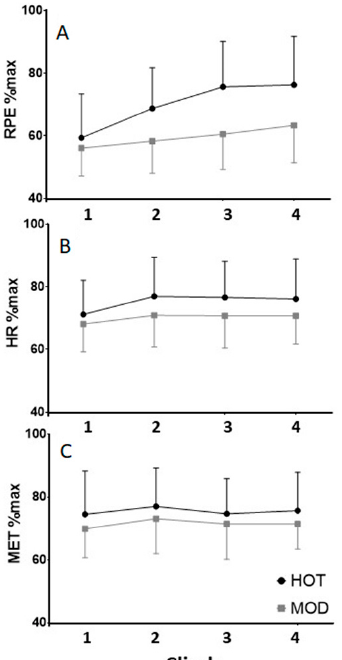
Figure 2. Percent of maximal values for ( A ) summit-station ratings of perceived exertion, ( B ) heart rate, and ( C ) work rate, during each climb.